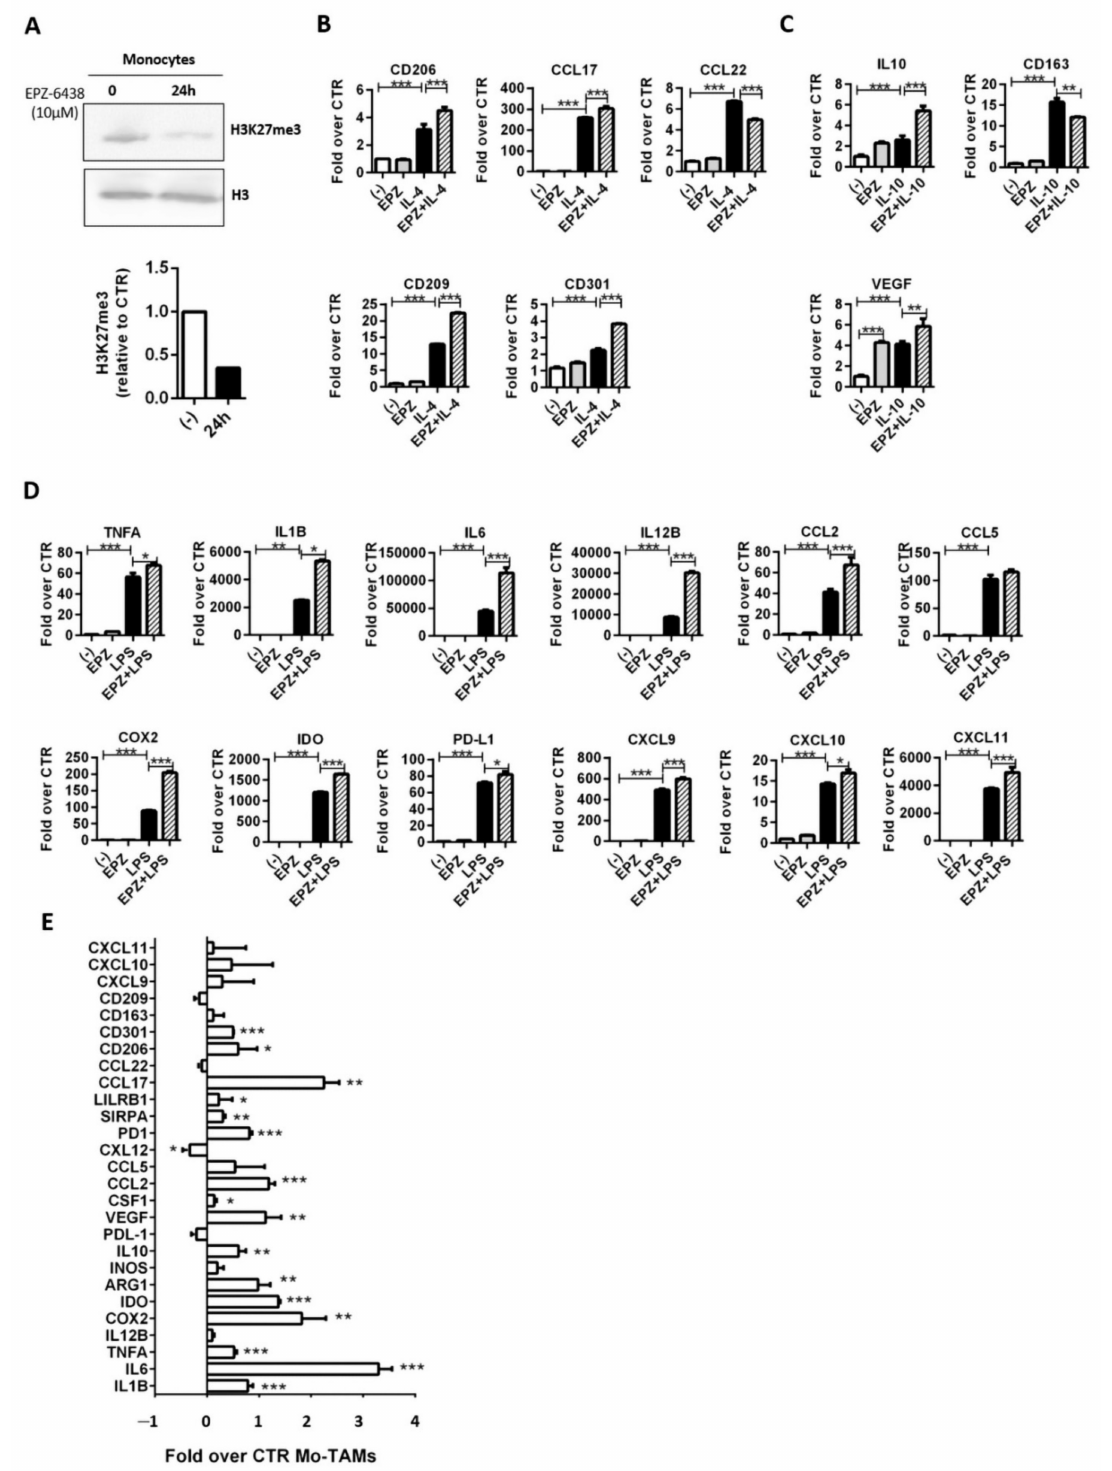
Figure 4. EZH2 inhibition affects human monocyte polarized activation. ( A ) Human monocytes were treated with 10 µ M EPZ-6438 or DMSO (-) for 24 h, then core histone proteins were extracted and analyzed by Western blot for H3K27me3 levels. Histone H3 was used as loading control; ( B , C ) cells were pretreated with EPZ-6438 (10 µ M) for 24 h and rechallenged with EPZ-6438 along with ( B ) IL-4 (20 ng/mL) or ( C ) IL-10 (20 ng/mL) for additional 18 h. Control cells were maintained in a medium supplemented with DMSO throughout the entire experimental period. An additional group of cells was treated with EPZ-6438 (10 µ M) for 42 h and M2-polarized monocytes were maintained in a medium supplemented with DMSO for 24 h and then stimulated with ( B ) IL-4 (20 ng/mL) or ( C ) IL-10 (20 ng/mL) for the last 18 h. The expression of